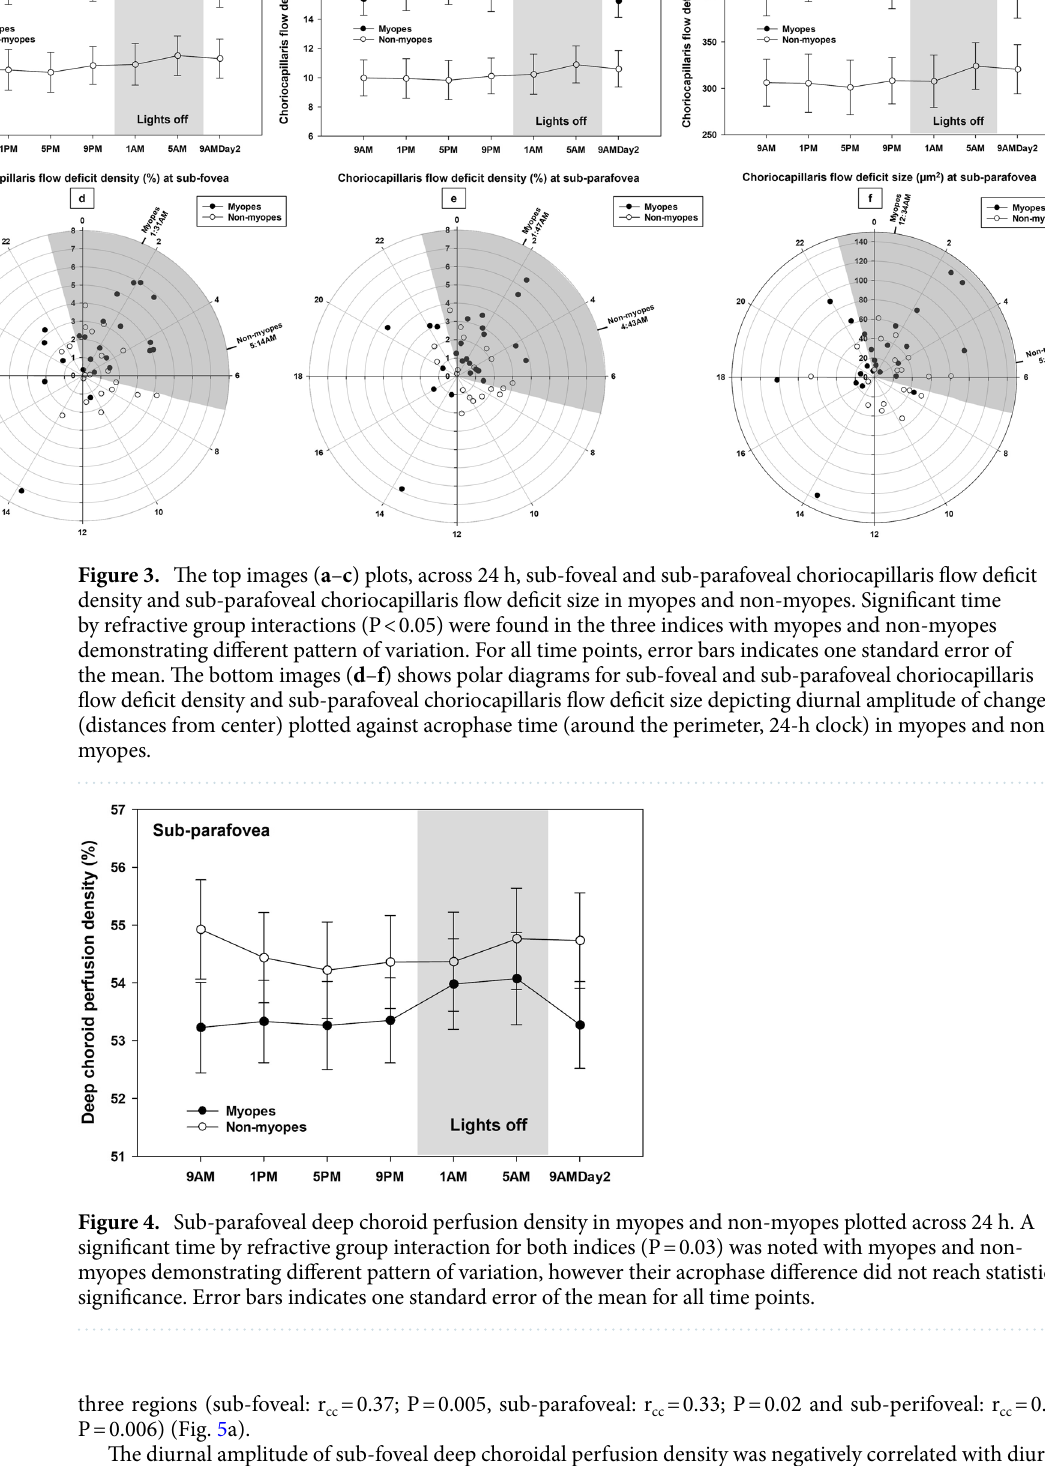
three regions (sub-foveal: r cc = 0.37; P = 0.005, sub-parafoveal: r cc = 0.33; P = 0.02 and sub-perifoveal: r cc = 0.36; P = 0.006) (Fig. 5a). The diurnal amplitude of sub-foveal deep choroidal perfusion density was negatively correlated with diurnal amplitude of IOP (r ρ = − 0.35; P = 0.028). The acrophases of the flow deficit measurements in the three regions were also negatively correlated with the acrophases of IOP (r cc = − 0.29 to − 0.47; P < 0.001). Both sub-foveal and sub-parafoveal flow deficit number diurnal amplitudes were negatively correlated with MAP (r ρ = − 0.32; P = 0.046 for both). The acrophase of pulse pressure were negatively correlated with the acro- phases of the flow deficit number and deep choroid perfusion density in the three regions (r cc = − 0.29 to − 0.32; P < 0.05) (Fig. 5b).